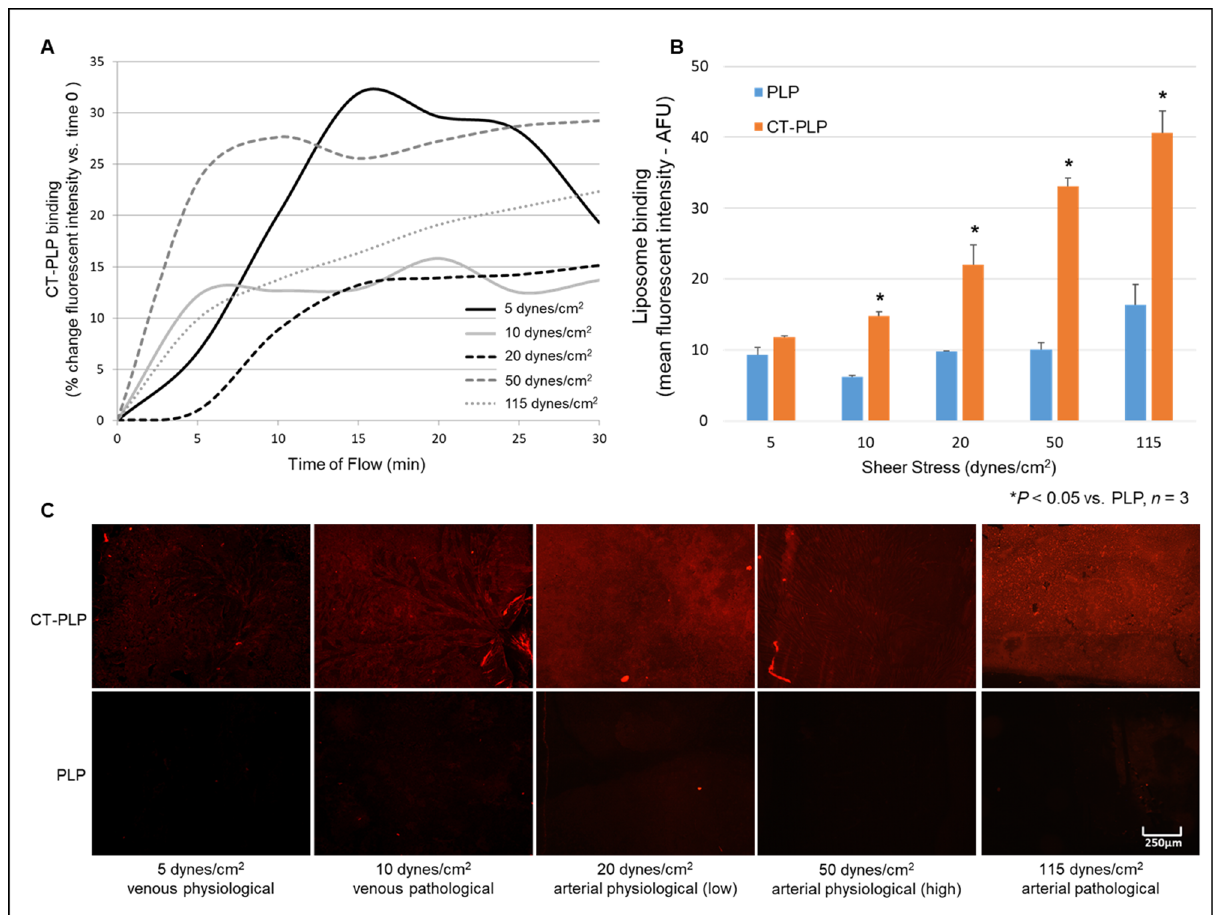
Figure 7. CT-PLPs bound to collagen IV matrices under a continuous flow. ( A ) At hemodynamic conditions, simulated at venous and arterial physiological and pathological sheer stress, CT-PLPs assembled with 5 mol % CTL via pre-insertion demonstrated increased binding over time. ( B ) After 45 min of a continuous flow, CT-PLP binding was significantly increased over PLP control binding at all simulated venous and arterial physiological and pathological sheer stresses. Binding was detected by the fluorescent microscopy of Rho-labeled lipids, and data were presented as the mean fluorescent intensity normalized to the background fluorescent intensity. ( C ) Representative fluorescent microscopy images showing Rho-labeled CT-PLP and PLP liposomes bound to collagen IV matrices after 45 min of a continuous flow at the simulated venous and arterial physiological and pathological sheer stresses.